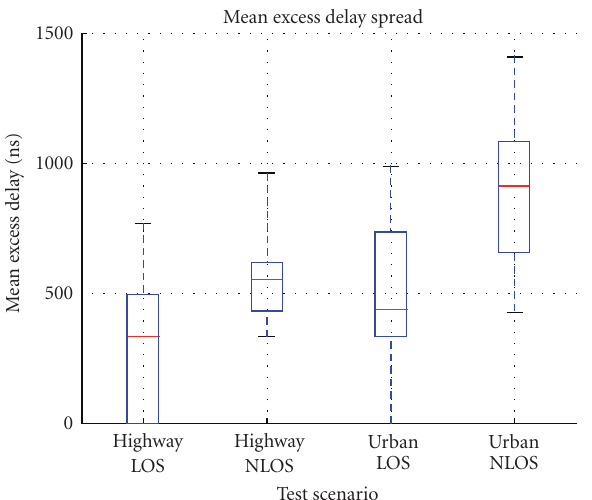
Figure 2: Comparison of mean excess delay for various scenarios.